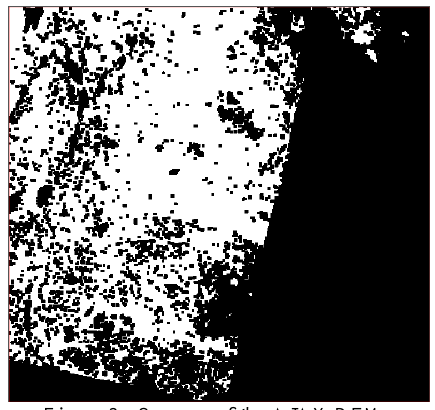
Figure 3 - Sources of the AJAX DEM. TerraSAR-X is shown in black, SPOT 5 HRS in white.